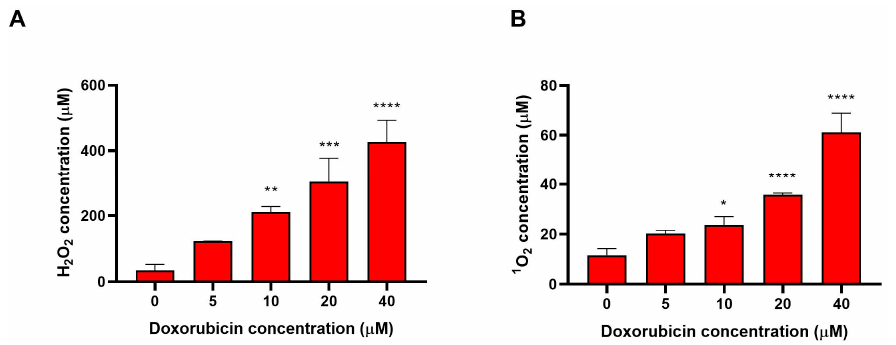
Figure 3. Quantification of ROS generated through type I ( A ) and type II ( B ) mechanisms as a function of doxorubicin concentration after 30 min of white light irradiation. ( A ) Amplex Red assay for H 2 O 2 detection. ( B ) ABMDMA assay for 1 O 2 detection. Results are expressed as mean ± SD. * p < 0.05; ** p < 0.01; *** p < 0.001; **** p < 0.0001 vs. control (doxorubicin 0 µM).